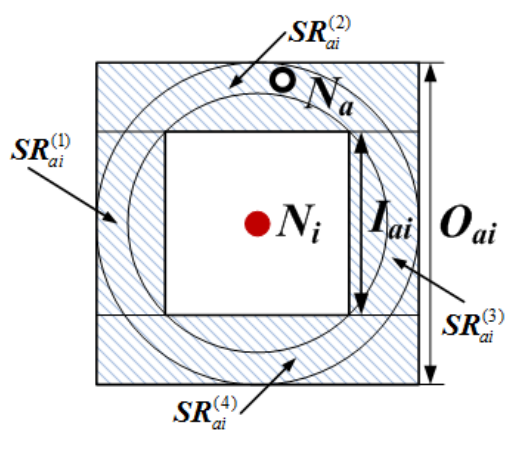
Figure A. Division of bounding square ring.